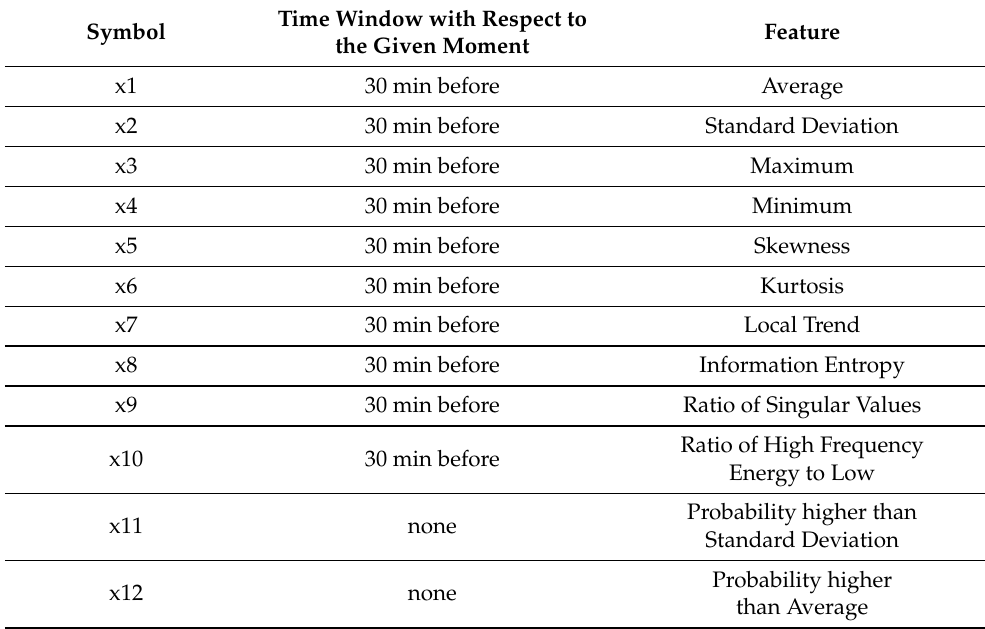
Table 2. Description of the extracted statistical features from the satellite-to-earth microwave signal. Time Window with Respect to Feature Symbol the Given Moment x1 30 min before Average x2 30 min before Standard Deviation 30 min before